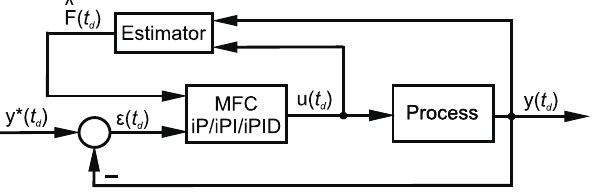
Figure 1. The CS structure with iP, iPI, and iPID controllers.